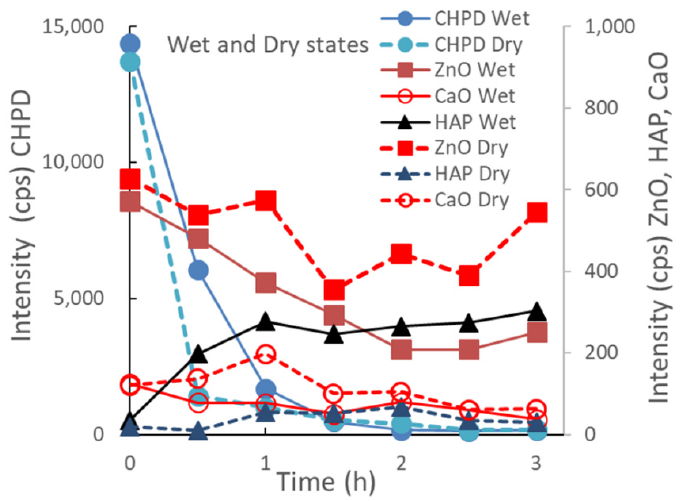
Figure 3. Changes in XRD peak height intensities of individual raw materials in the S-CP during wet or dry grinding.